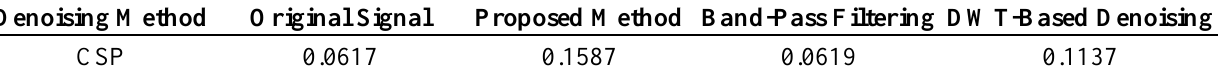
Table 5. The CSP values for the denoising results of different methods for inner-race defective